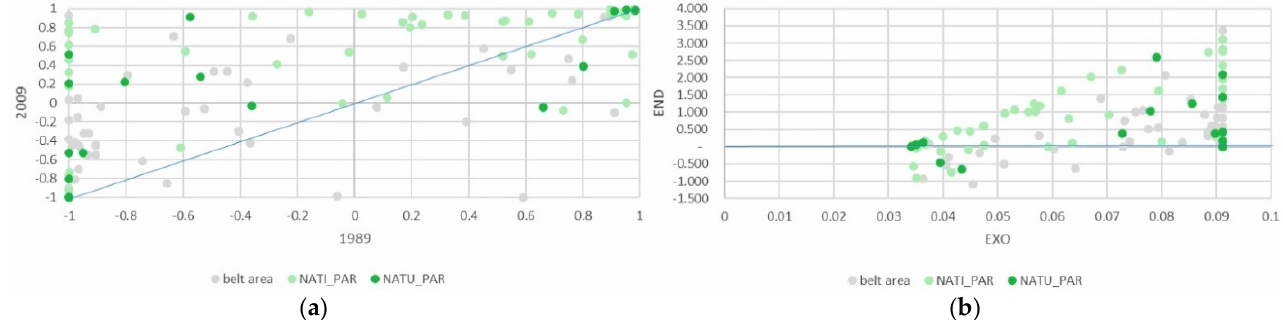
Figure 8. ( a , b ) Sierra Nevada- PSI and DPSI of pasture meadows. Source: Drawn up by the authors using data from the 1989 and 2009 Agrarian Censuses, Ministry of Agriculture.